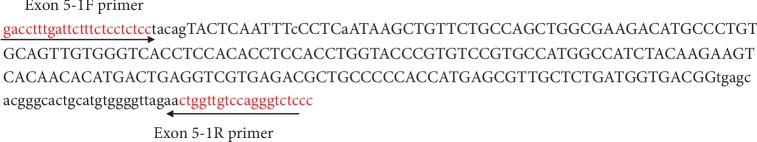
Nucleotide sequence of the amplified PCR product (265 bp) representing exon 5 of rat p53 gene in the control group.